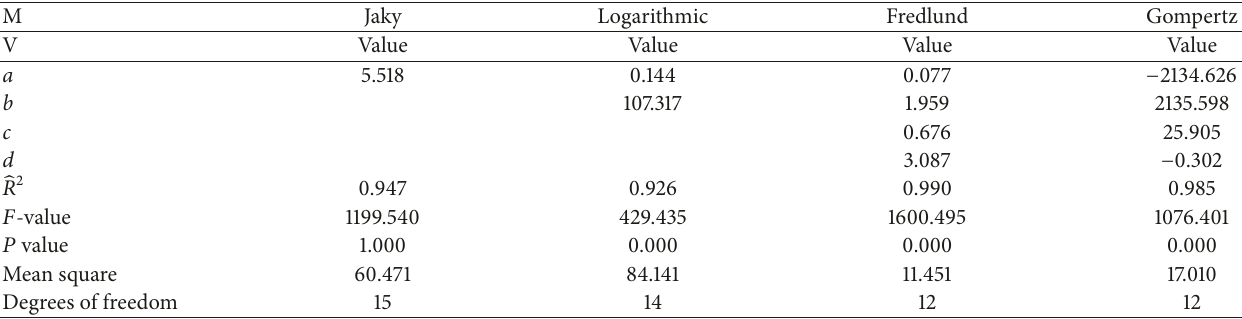
Table 7: Fitting parameters of L-3 by sieve-pipette method.